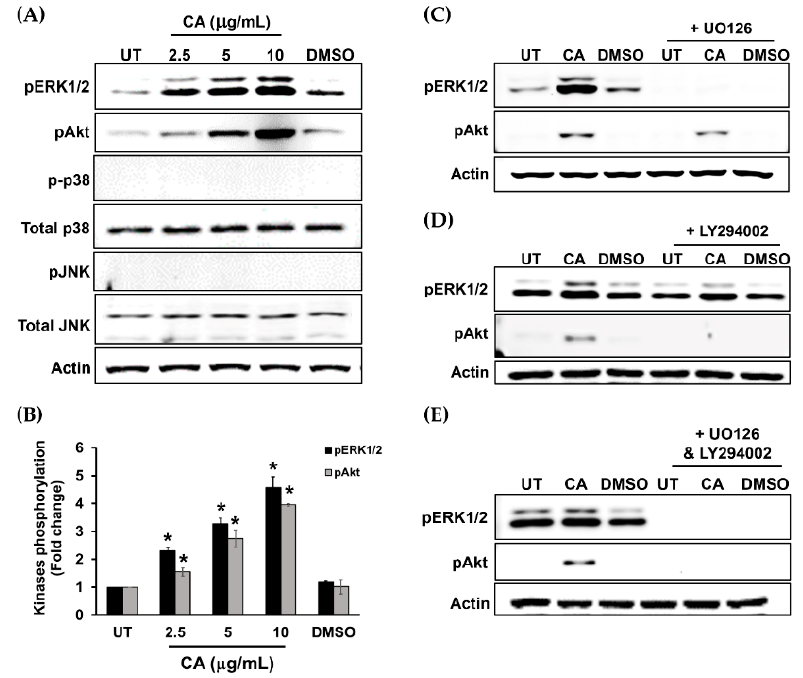
Figure 9. U0126 and LY294002 inhibited CA extract-induced ERK1/2 and Akt phosphorylation. ( A )